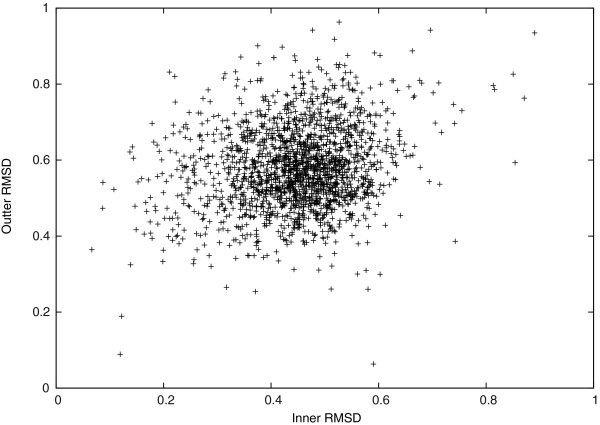
Cα-RMSD of inner regions v.s. outer regions.